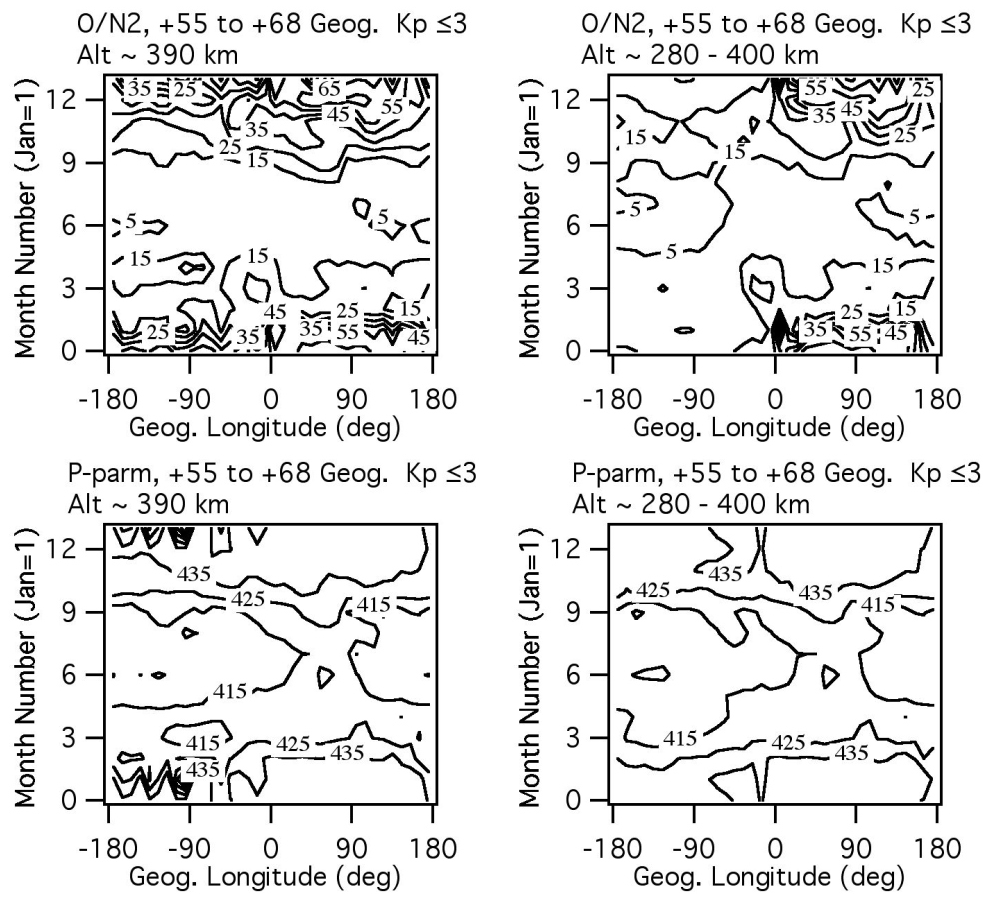
Fig. 2. Contour plots for geographic latitudes 55 ◦ N to 68 ◦ N for K p ≤ 3, versus longitude and month. Above: Neutral O/N 2 concentration ratio at heights 390km (left), 280–400km (right). Below: P -parameter at heights 390km (left), 280–400km